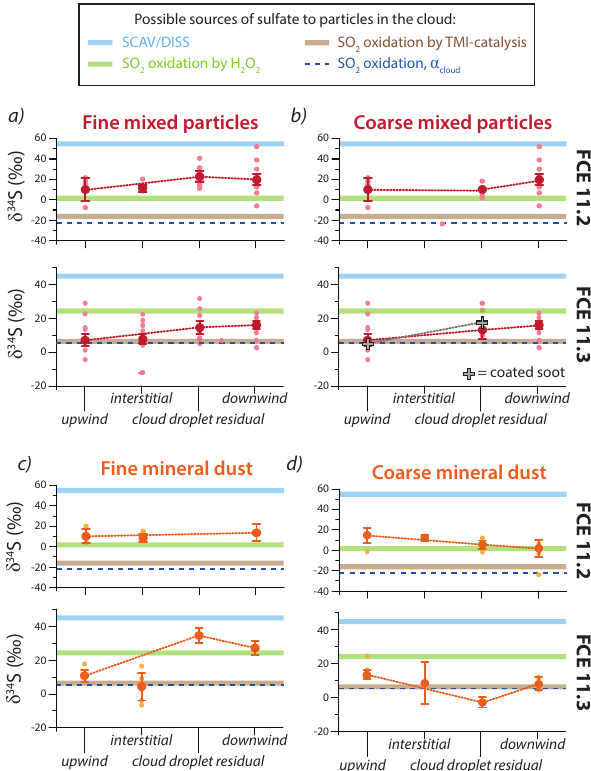
Fig. 5. Isotopic composition of particles measured during HCCT- 2010 for cloud events 11.2 and 11.3: (a) fine mixed particles ( = OA + salt), (b) coarse mixed particles, (c) fine mineral dust, (d) coarse mineral dust. Mixed particles are shown in red and mineral dust in orange. Size-resolved mixed particles could only be measured in cloud droplet residual; upwind and downwind results are there- fore equal for fine and coarse particles. In (b) for FCE 11.3 sulfur was also measured in coated soot particles, shown as grey crosses. Straight thick lines (blue, green and brown) show the isotopic com- position of sulfate that could be added to particles in the cloud from different sources according to the legend, and the dashed dark blue line shows the sulfate that would have been added from the SO 2 re- moval ( α cloud ) as discussed in Harris et al. (2013) (values given in Table 4). Pale circles show measurements for individual grains and larger, dark circles with error bars show the mean and the 1 σ error. Dotted lines follow from upwind to in-cloud to downwind particles and show the change in δ 34 S due to cloud processing.